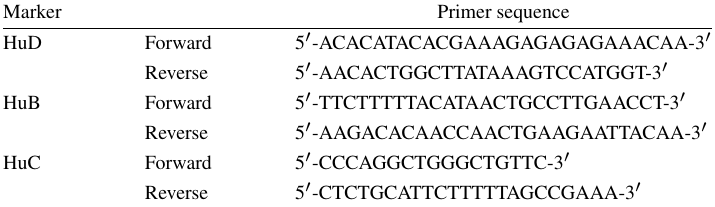
nELAV-like primer sequences used in real-time RT-PCR